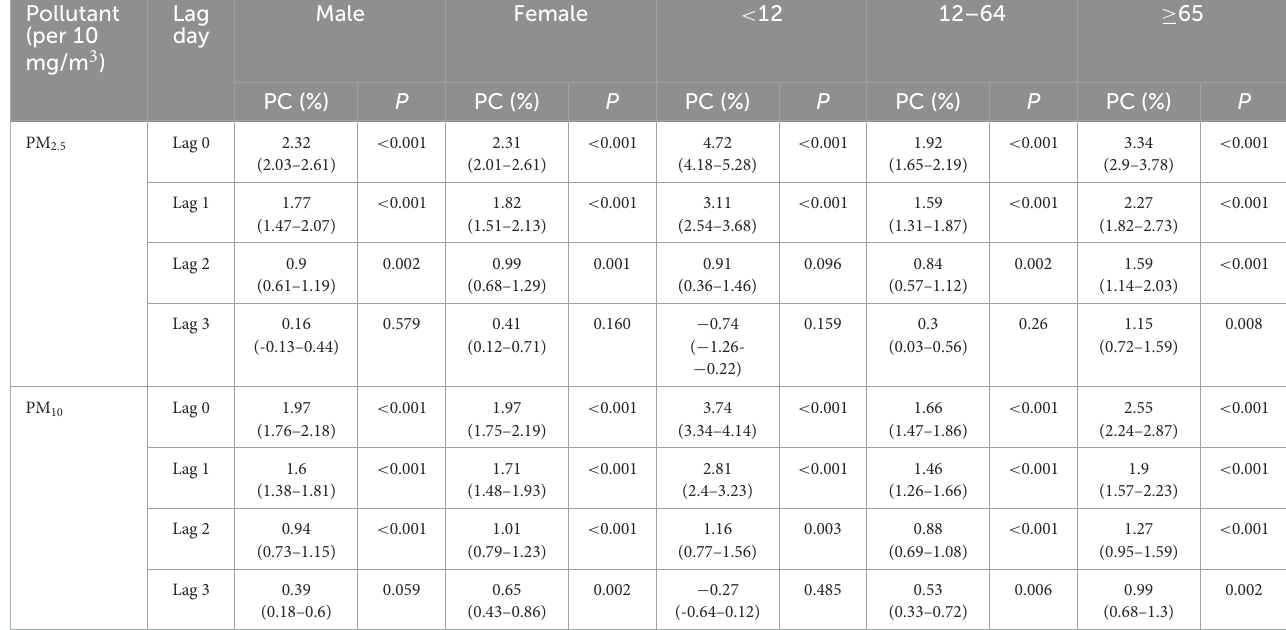
TABLE 6 Stratification analysis of the percent change of eczema risk associated with 10 mg/m 3 increase of PM 2.5 and PM 10 . Pollutant (per 10